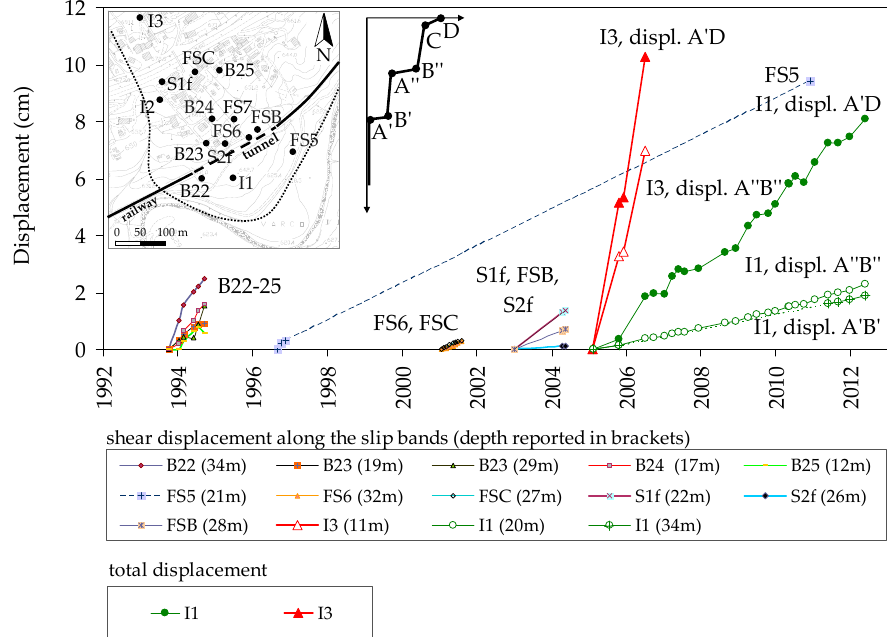
Figure 7. Deep and total displacements in different areas of the Varco d’Izzo earthflow, obtained from inclinometer data (redrawn from Di Maio et al. [42]).